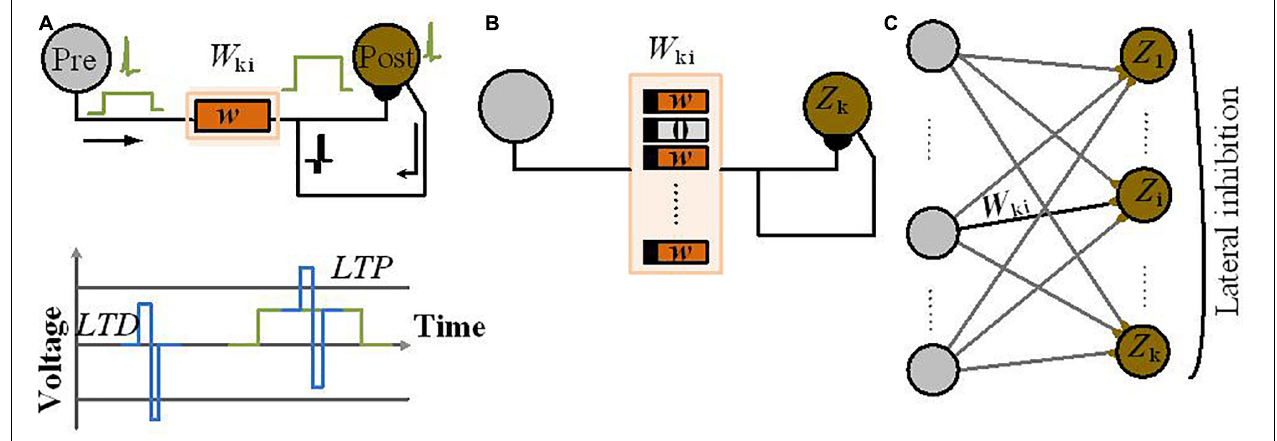
FIGURE 13 | (A) STDP pulsing scheme along with pre- and postsynaptic spikes behavior for LTP and LTD phenomena. (B) Stochastic memristors construct the compound memristive synapse. (C) The winner-take-all mechanism in SNN with compound memristive synapses.